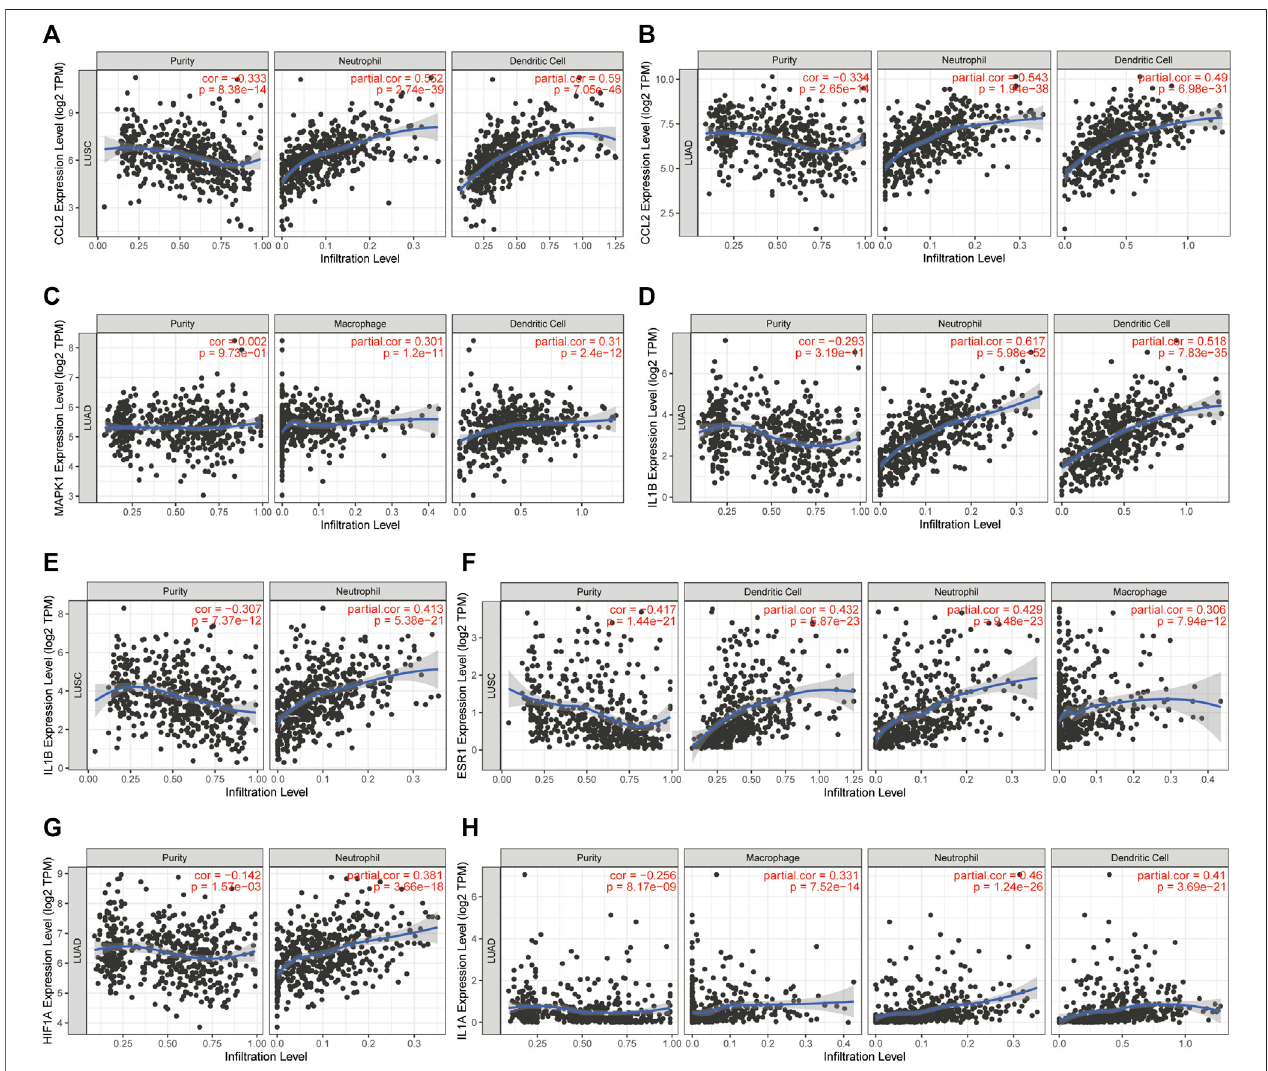
FIGURE 8 | The correlation between CCL2 (A,B) , MAPK1 (C) , IL1B (D,E) , ESR1 (F) , HIF1A (G) , and IL1A (H) from 15 hub genes with different immune cells in fi ltrated in lung adenocarcinoma (LUAD) and/or lung squamous cell carcinoma (LUSC) from TCGA.